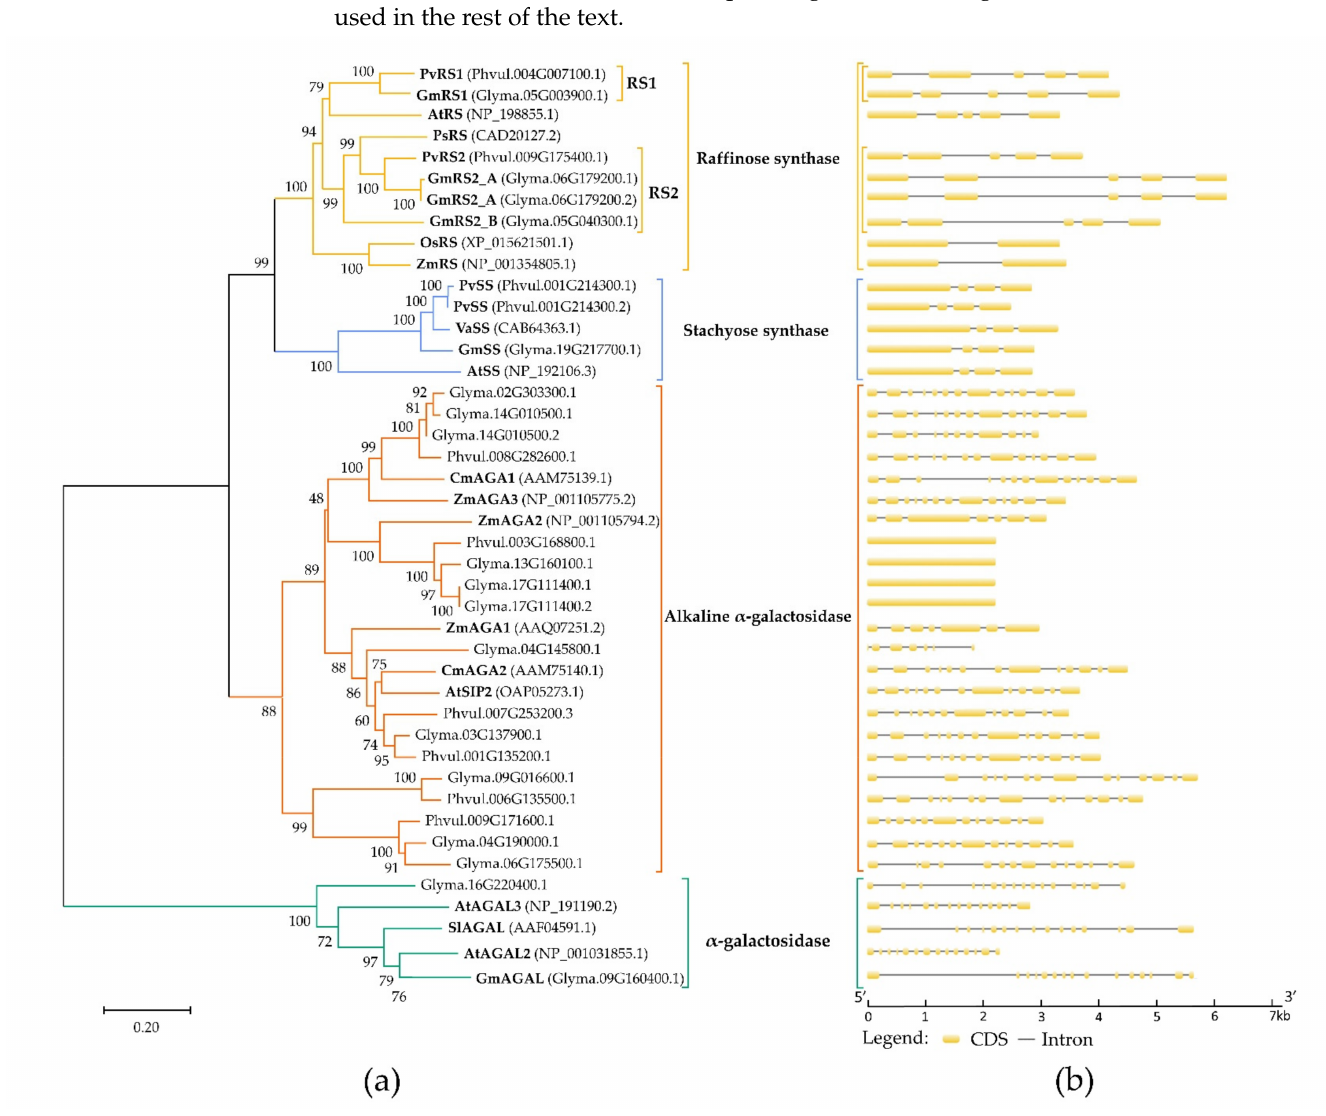
Figure 2. Analysis of the phylogenetic relationships and gene structures of the raffinose family oligosaccharides’ biosynthetic and catabolic enzymes. ( a ) Evolutionary relationship of the raffinose synthase (RS), stachyose synthase (SS) and (alkaline) α -galactosidase (AGA) enzymes of G. max , P. vulgaris and other well-characterized enzymes of different taxa ( A. thaliana , P. sativum , V. angularis , S. lycopersicum , O. sativa and Z. mays) . The RS enzymes of P. vulgaris and G. max are subdivided into two different classes (RS1 and RS2) based on their clustering. The phylogenetic tree was made in MEGA X (v10.2.4) using the neighbor-joining algorithm combined with a bootstrap test of 1000 replicates (next to the branches are the percentage of replicate trees in which the associated taxa clustered together is shown) [46–48]. The Poisson correction method was used to compute the evolutionary distances with the number of amino acid substitutions per site as a unit [49]. The phylogenetic tree was drawn to scale using the calculated evolutionary distances as branch lengths. This analysis involved 43 amino acid sequences. For each sequence pair, all ambiguous positions were removed using the pairwise deletion option and the final dataset consisted of 1030 positions. The multiple sequence alignment was created using the MUSCLE algorithm. ( b ) Structures of genes encoding the RFO synthase enzymes were visualized using GSDS software